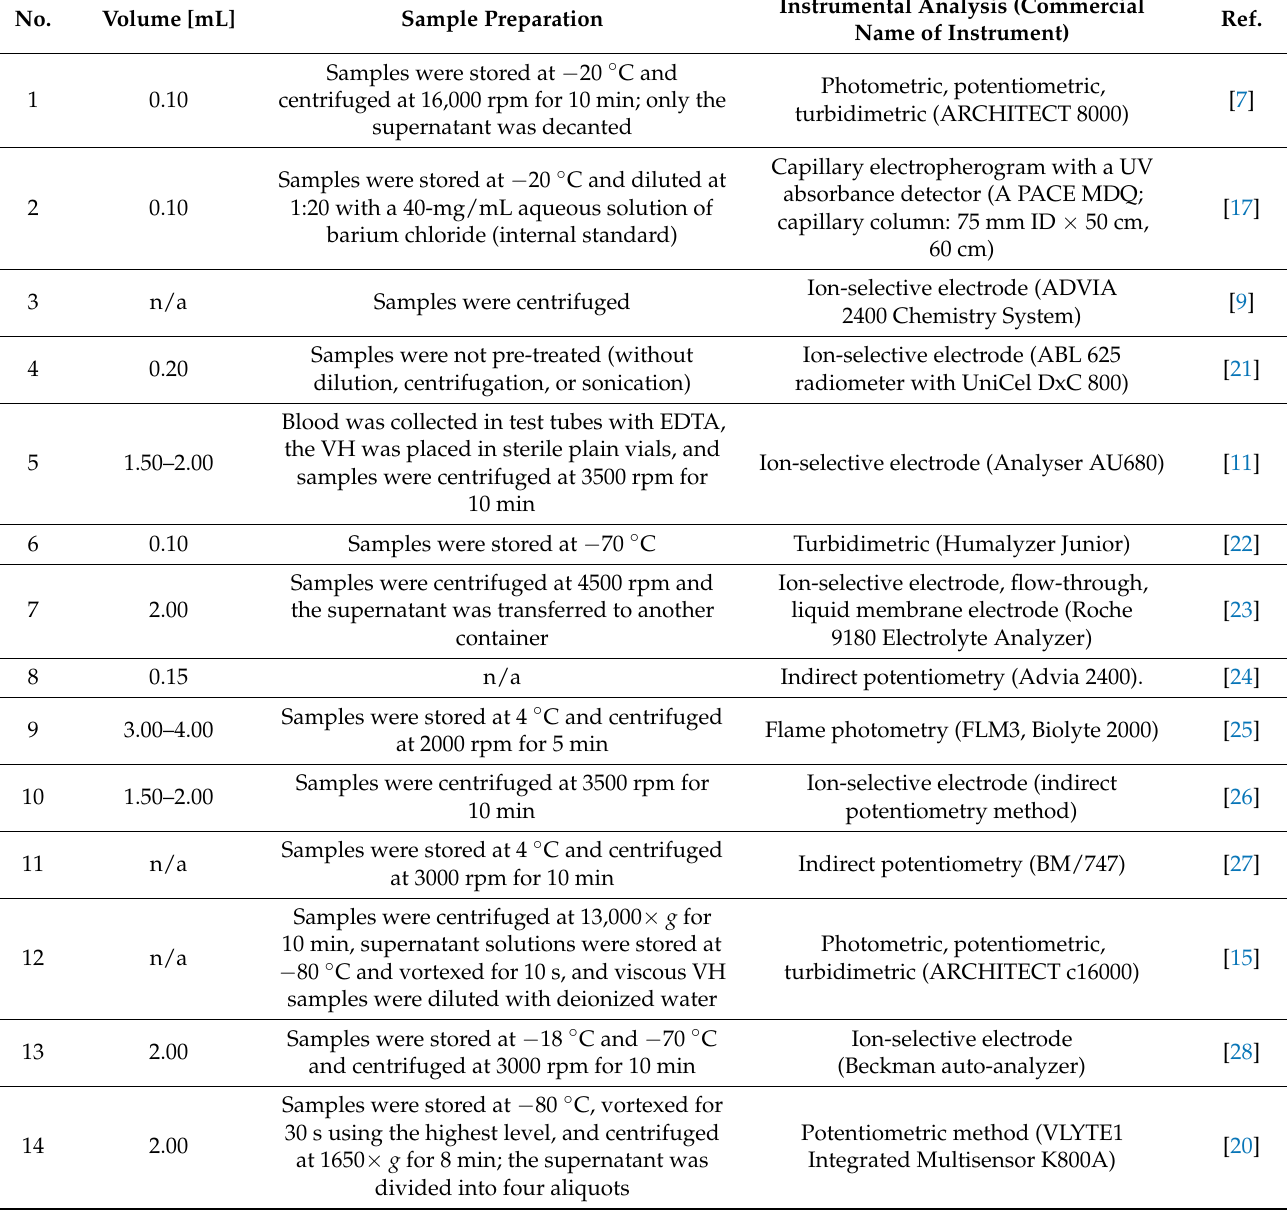
Table 2. Methods applied to determine the postmortem concentration of potassium ions in the